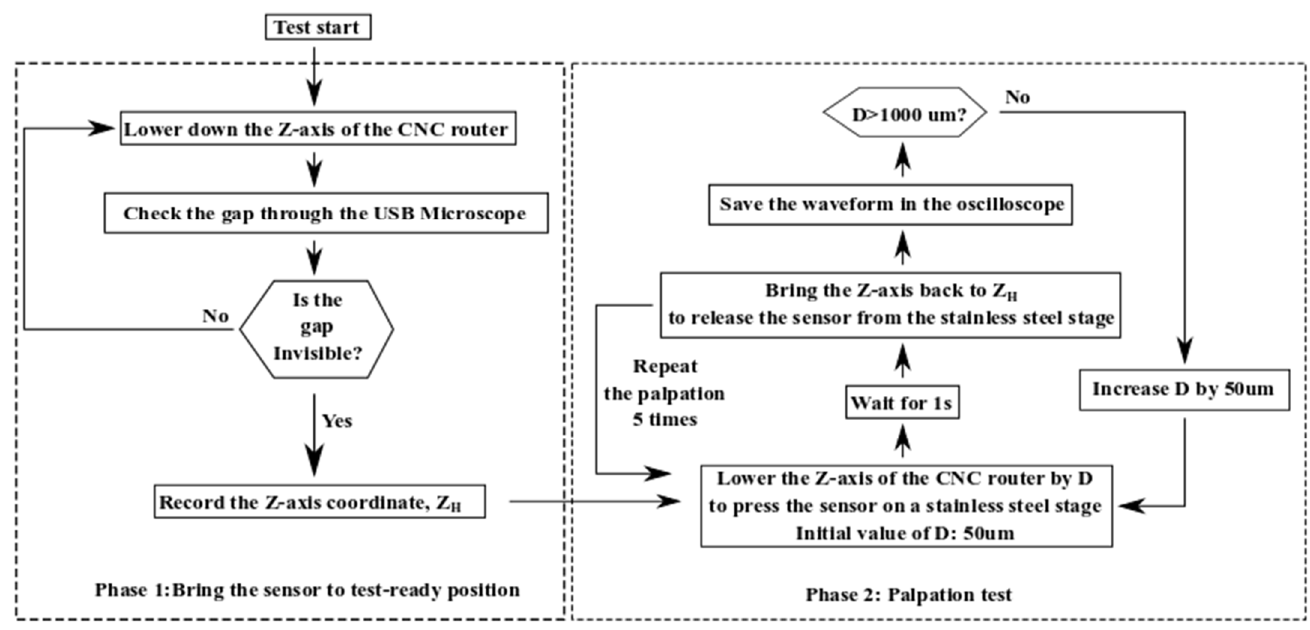
Figure 6. The procedure to measure the tactile sensor’s sensitivity to pressing depth during palpa ‐ tion.